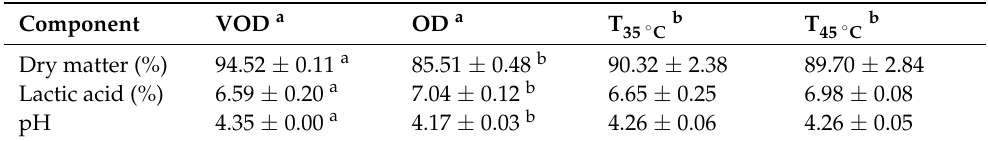
Table 4. Individual effect of drying technique and drying temperature on some physico-chemical properties of Kurut samples.